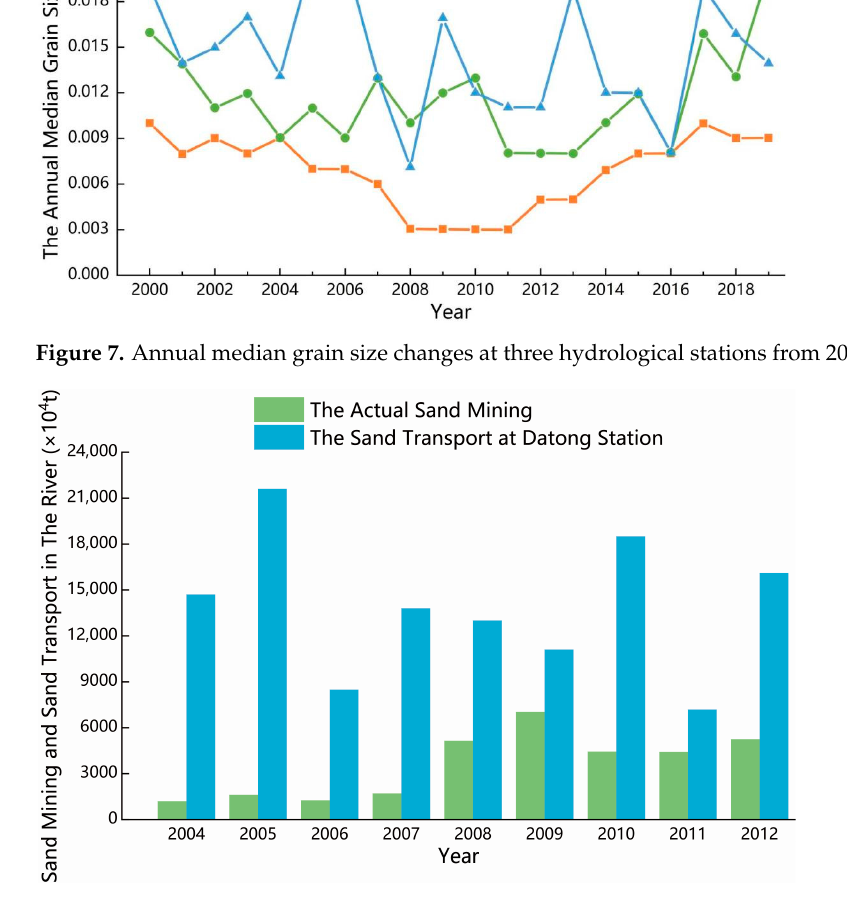
Figure 8. Comparison of sand mining and sand transport in the river at Datong